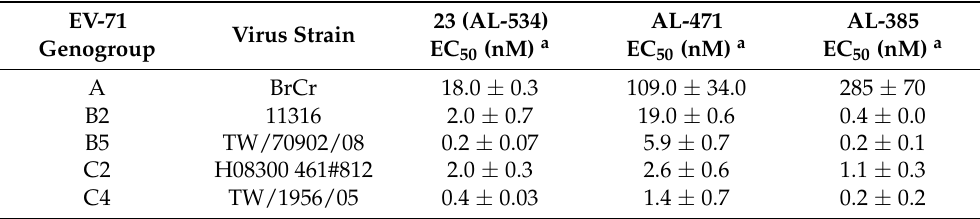
Table 4. Evaluation of the broad-spectrum antiviral effect of 23 ( AL-534 ) against a representative panel of clinical EV-71 isolates in RD cells.